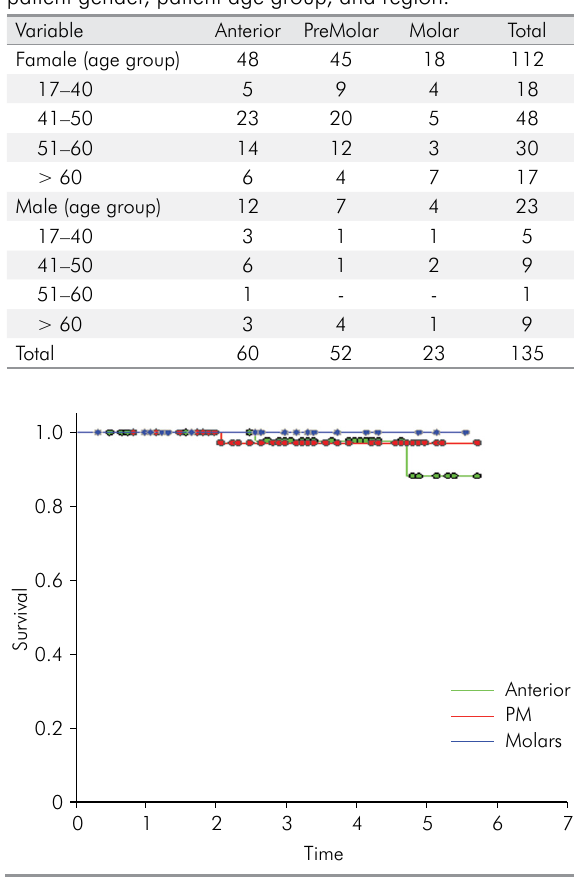
Figure 1. Kaplan Meier survival curve of metal-ceramic single crowns, comparing the region of the crown. Is possible observe that anterior and PM regions presented failures, while molar region did not.